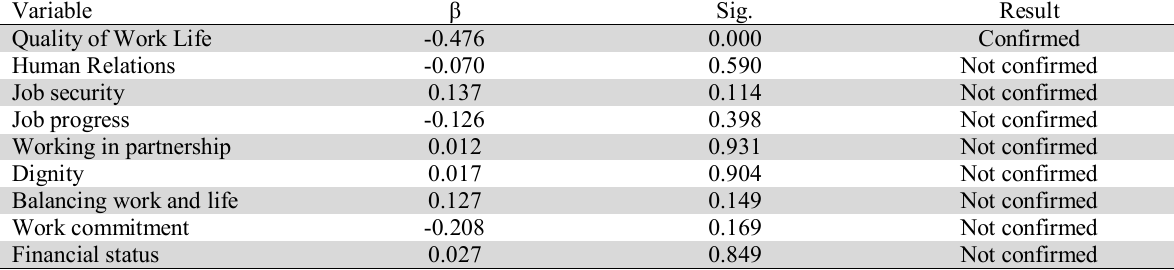
The results of the relationship between mental health and quality of life Variable β Quality of Work Life